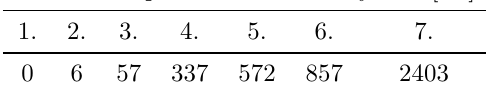
Table 1. Natural frequencies overview [3].